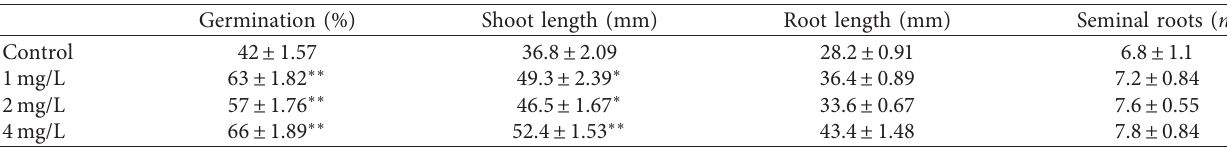
Table 1: The germination percentage of seeds, shoot length, root length, and number of seminal roots in H. vulgare L. seedlings grown 7 days with 0, 1, 2, and 4mg/L of ZnO